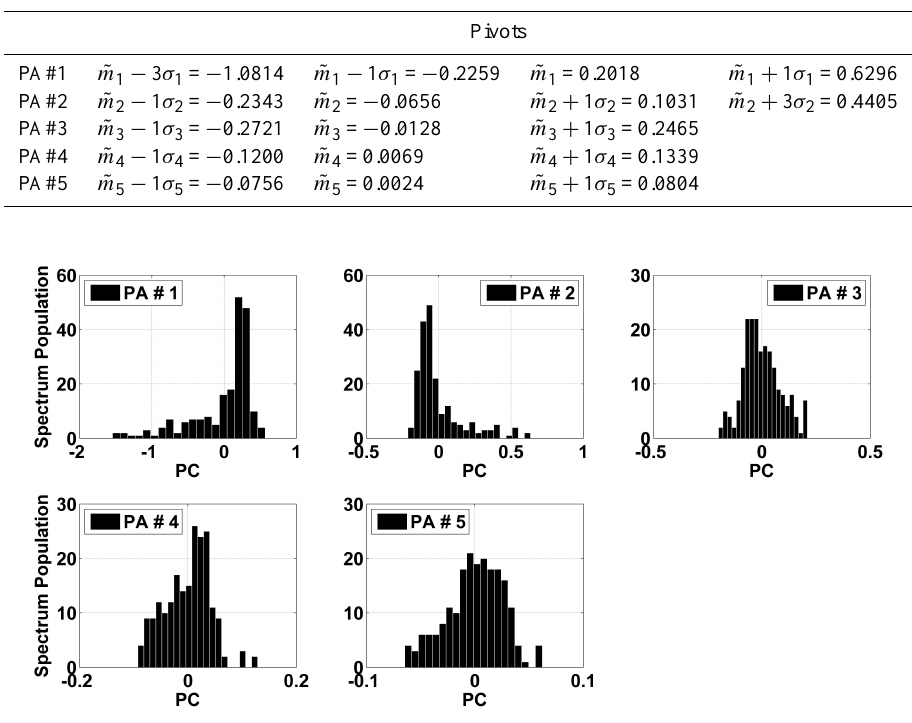
Fig. 5. Distribution of the PCs of the CIRA-86 dataset along the five first principal axes. From these distributions, pivots can be defined in order to generate a training dataset of non-redundant